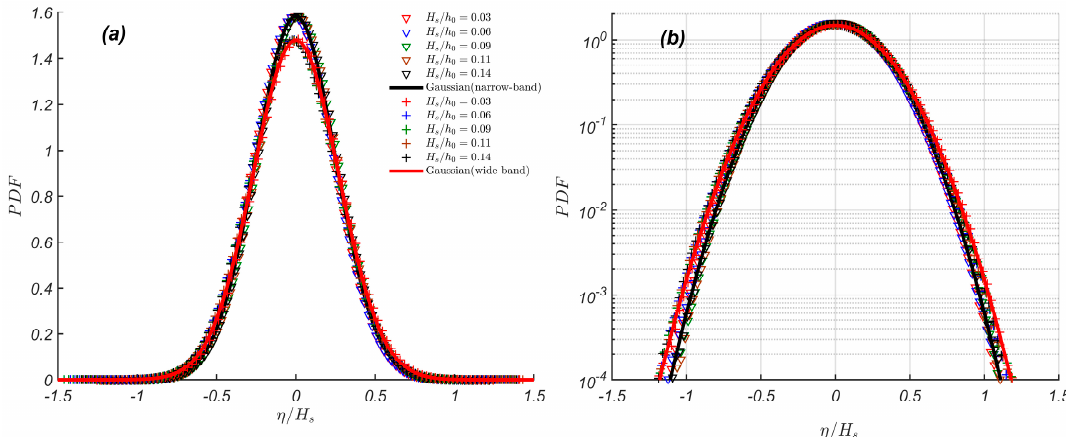
Figure 2. Probability density functions of normalized narrow-band and wide-band wave fields o ff shore for di ff erent nonlinearities, H s / h 0 in linear ( a ) and logarithmic ( b ) scales. Solid lines correspond to Gaussian distributions fitted to the corresponding datasets, shown with a red color for wide-band data and with black color for narrow band